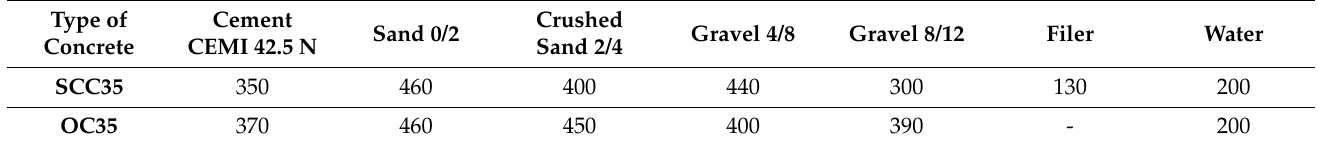
Table 5. Composition of 1m 3 of concrete.